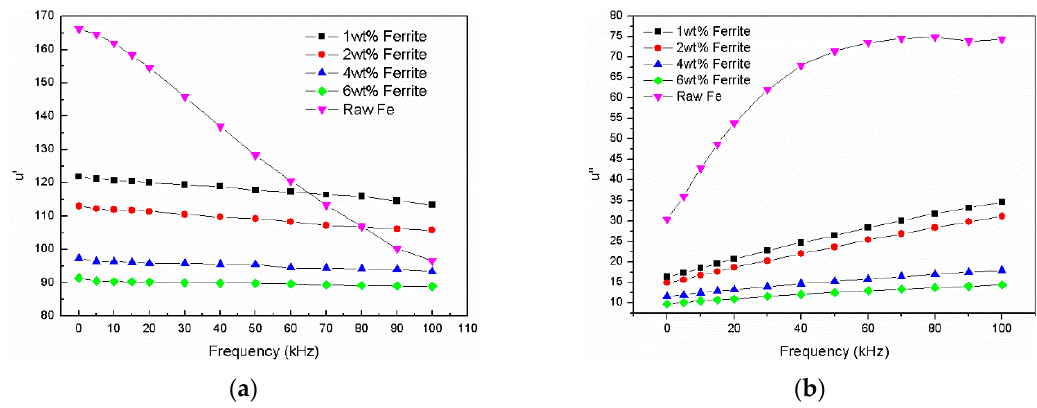
Figure 8. Permeability of Fe/Fe 3 O 4 -MnZnFe 2 O 4 cores at frequency range of 1 kHz to 100 kHz: ( a ) real part permeability; ( b ) imaginary part permeability.